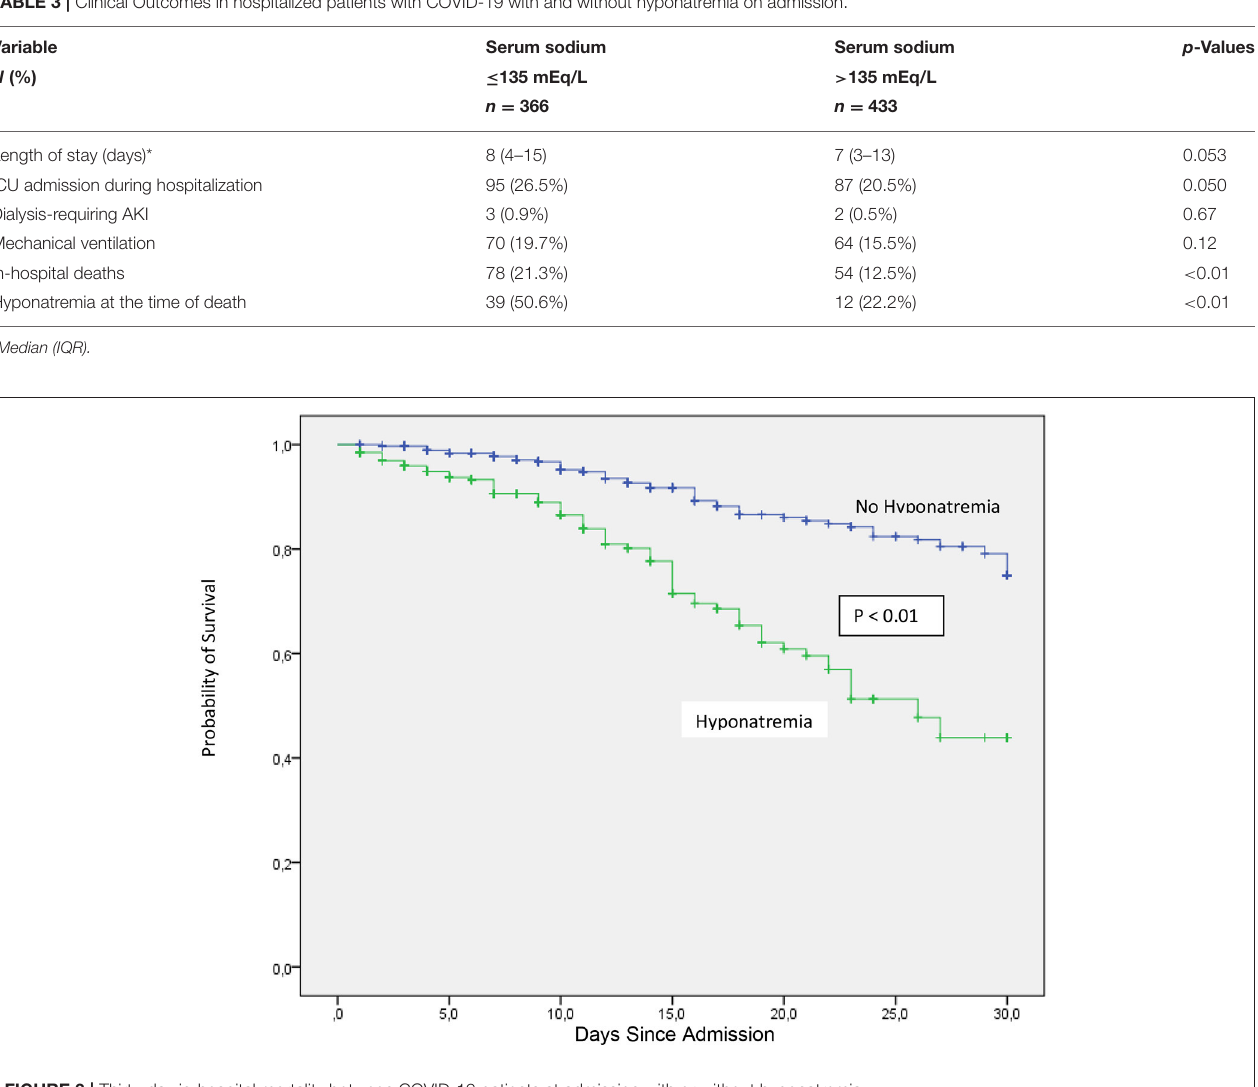
FIGURE 3 | Thirty-day in-hospital mortality between COVID-19 patients at admission with or without